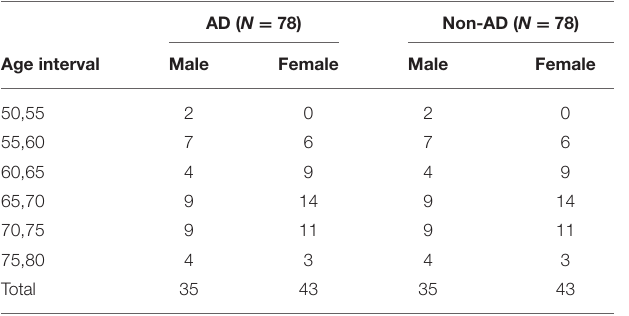
TABLE 1 | The basic composition of the participants in every group.